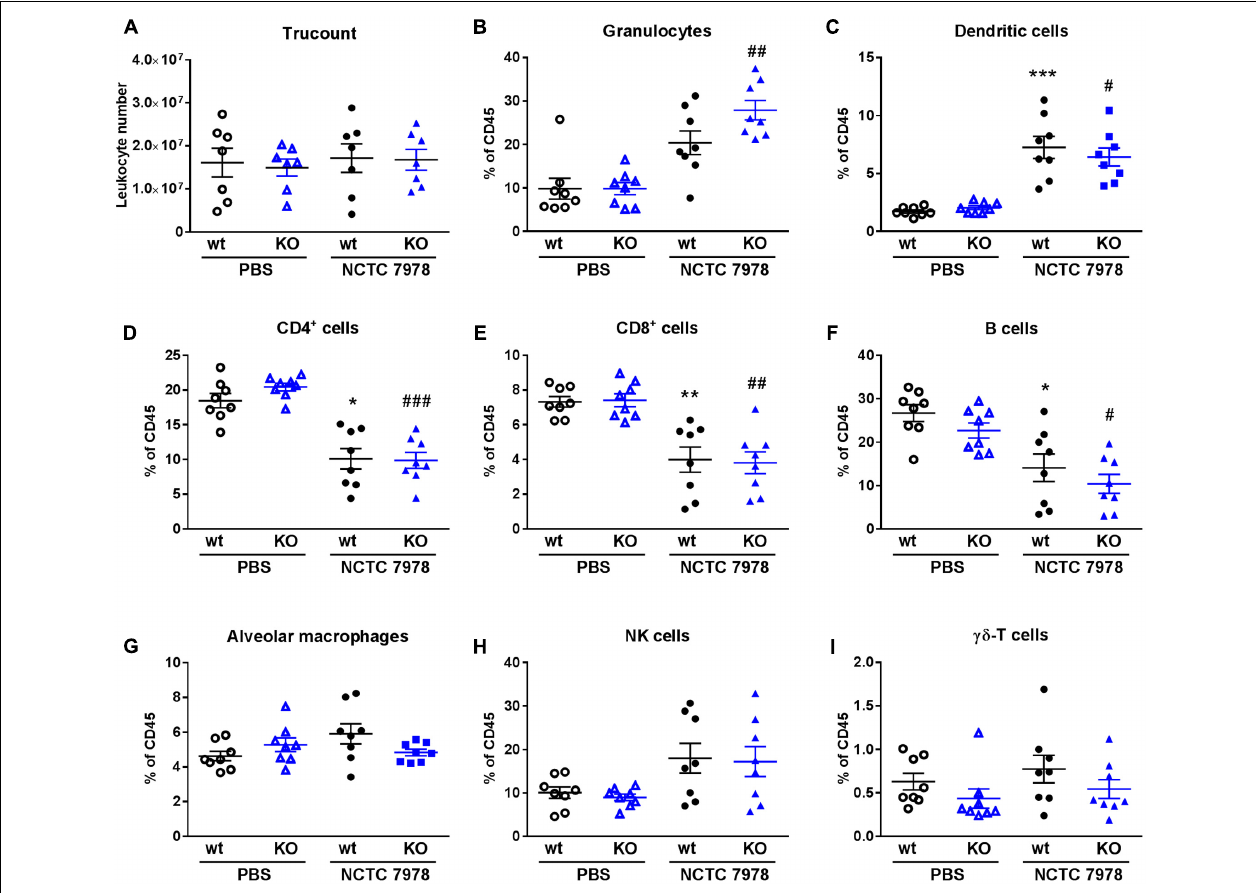
FIGURE 4 | Comparison of the cell population in the lung. BALB/c wt and PGLYRP3KO mice were intranasally infected with 10 5 CFUs S. pneumoniae (NCTC 7978) per mouse for 48 h. The amount of total leukocyte numbers and different CD45 + cell populations were analyzed by flow cytometry in whole lung homogenates. The numbers of leukocytes do not vary between the different conditions (A) . The proportional amount out of CD45 + cells (% of CD45) were shown for granulocytes (B) , DCs (C) , CD4 + T cells (D) , CD8 + T cells (E) , B cells (F) , AMs (G) , NK cells (H) and γδ -T cells (I) . Eight animals per group (mean ± SEM); Kruskal–Wallis with Dunn’s multiple comparison test: uninfected vs. infected wt: ∗ p < 0.05; ∗∗ p < 0.01; ∗∗∗ p < 0.001 and uninfected vs. infected PGLYRP3KO: # p < 0.05; ## p < 0.01; ### p <